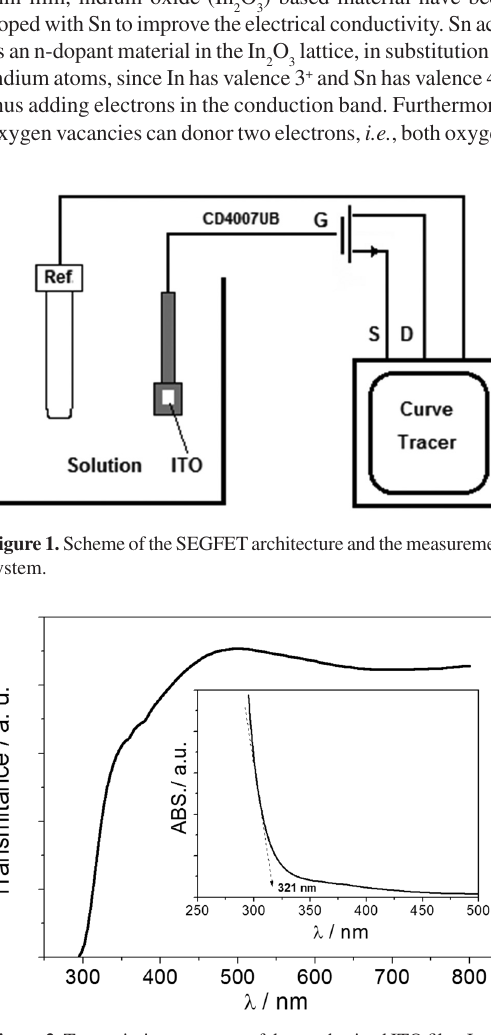
Figure 3. X-ray diffraction of ITO film deposited onto glass substrate. The peaks of the In O powders are shown for 2 3